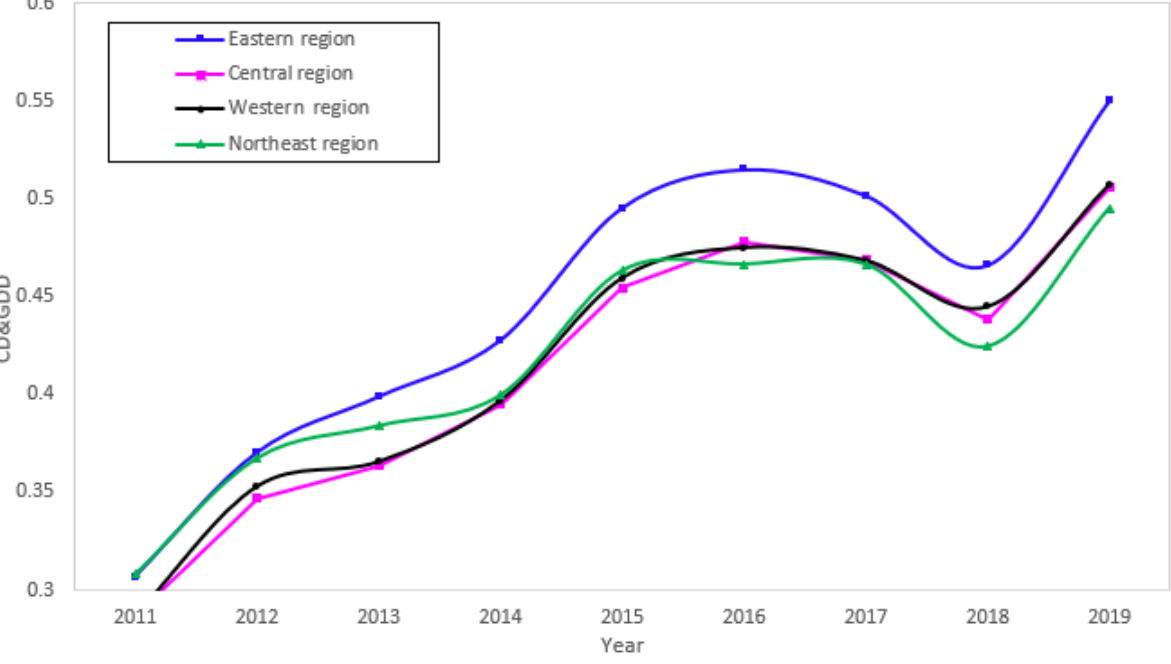
Figure 4. Changes in average values of CD&GDD in China’s four major economic zones from 2011 to 2019.